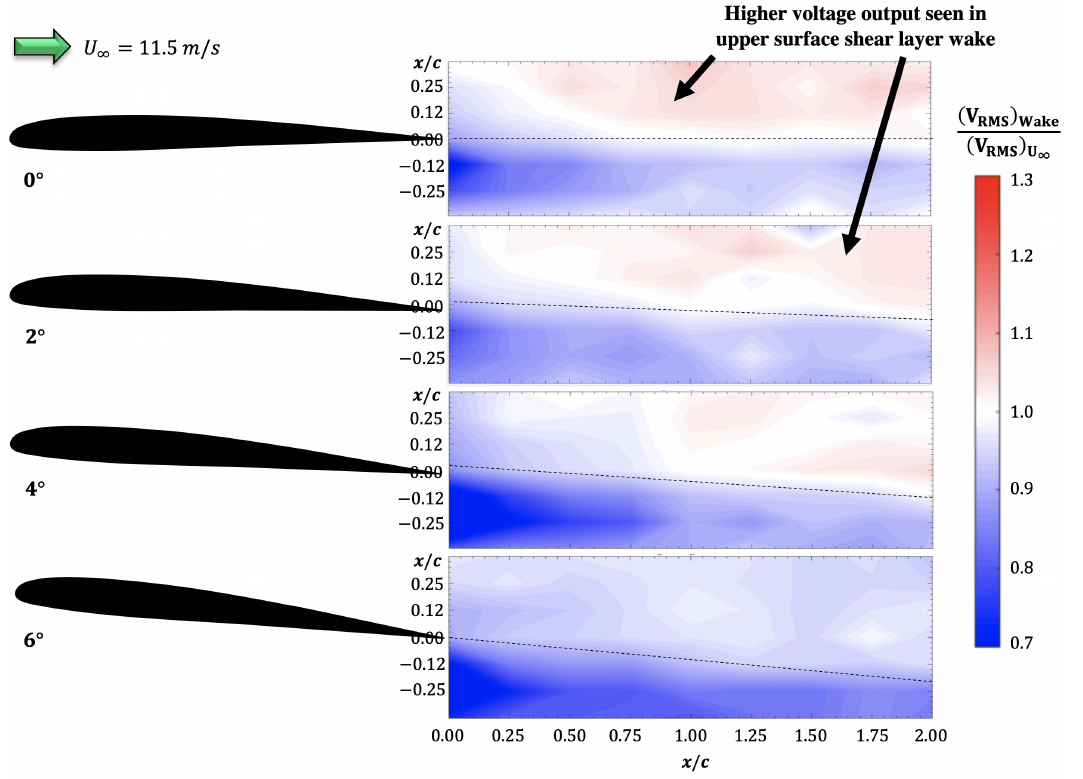
Figure 23. Normalized Voltage RMS contours in the wake of SD7003 airfoil for multiple angles of attack. A surprising pattern in the voltage output was seen where V RMS increased in the upper surface shear layer and decreased in the lower surface shear